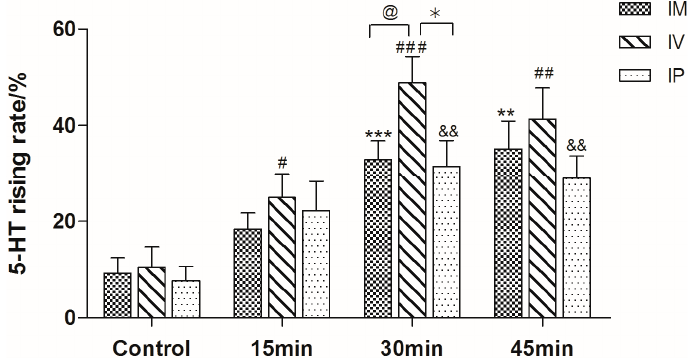
Figure 3. Rising levels of serotonin in guinea pig plasma after treatment in different ways (IM: intramuscular injection; IV: intravenous injection; IP: intraperitoneal injection). ** p < 0.01, *** p < 0.001 vs. IM control, # p < 0.05, ## p < 0.01, ### p < 0.001 vs. IV control, && p < 0.01 vs. IP control, @ p < 0.05 vs. IM, * p < 0.05 vs. IP group ( n = 10).